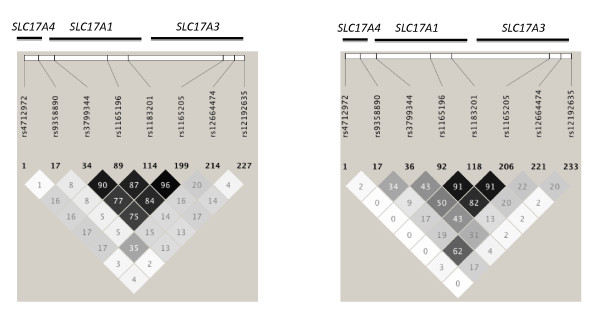
Intermarker linkage disequilibrium for Caucasian and Chinese populations. Intermarker linkage disequilibrium r2 values for Caucasian (Centre d'Etude du Polymorphisme Humain; left) and Chinese (Han Chinese Beijing; right) populations. Approximate gene positions are shown. Diagram generated with Haploview using data from www.hapmap.org.